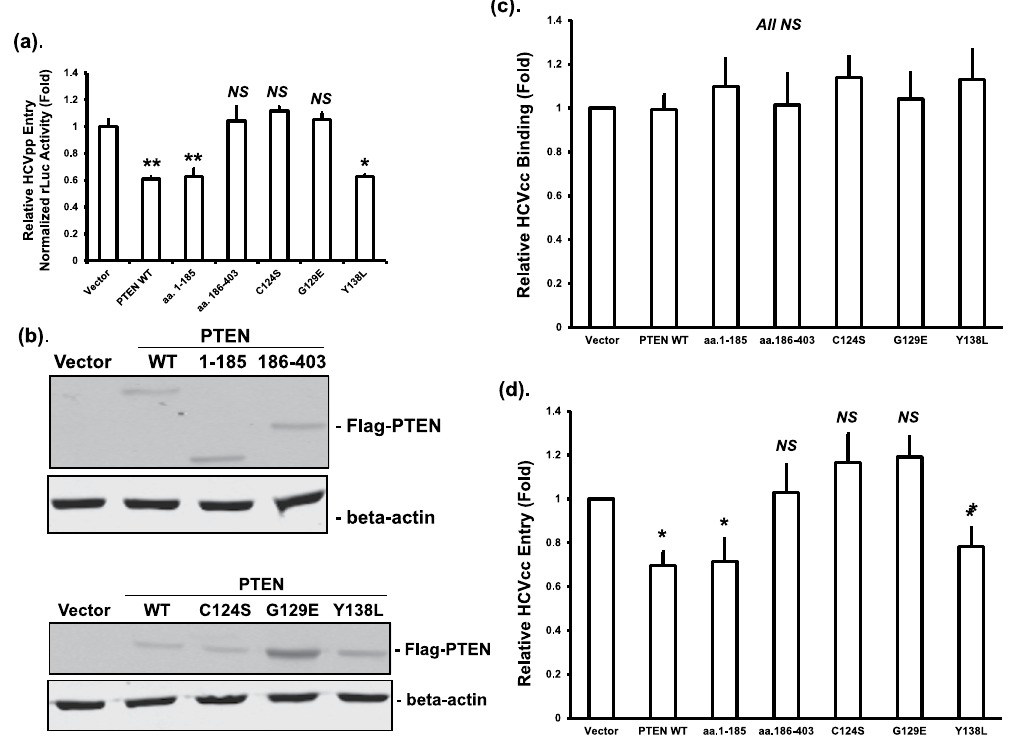
Figure 2. PTEN inhibits HCV entry through its lipid phosphatase activity. ( a ) Huh-7.5 cells were transfected with plasmids expressing wild-type Flag-PTEN (PTEN WT), truncated mutants, phosphatase deficient mutants, or empty vector. Forty eight hours after transfection, cells were infected using HCV-2a J6 pseudoparticles with a firefly luciferase reporter (HCVpp-Luc). Luciferase activity was measured 24 hours after infection and normalized to total protein amount. Luciferase activities were expressed as fold changes relative to vector control. Statistical differences between samples were demonstrated as * if p ≤ 0.05, ** if p ≤ 0.01, or NS for not significant. This experiment was performed three times. ( b ) The protein levels of Flag-tagged PTEN after transfection were determined by Western blotting using an anti-Flag antibody. The β -actin levels were determined by blotting cell lysates with a β -actin antibody as loading controls. ( c and d ) Huh-7.5 cells were transfected with plasmids expressing wild-type PTEN (PTEN WT), truncated mutants, phosphatase deficient mutants, or empty vector, and infected with HCV-2a J6 core-Flag/JFH-1 (p7-rLuc-2A) virus 48 hours after transfection. After incubation at 4 °C for 1 hour ( c , virus binding only) or after a further incubation at 37 °C for 3 hours ( d , post-binding entry), cells were harvested and RNA extracted. HCV RNA levels were quantified by real-time PCR. Statistical differences between samples were demonstrated as ** if p ≤ 0.01, * if p ≤ 0.05, or NS for not